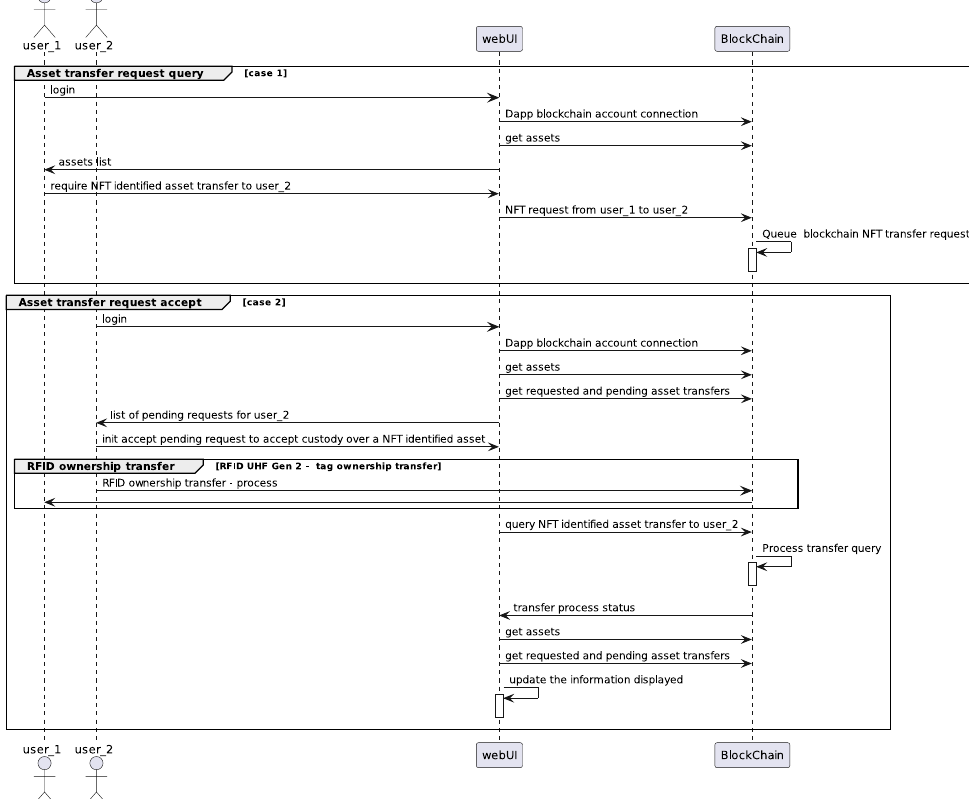
Figure 6. Ownership transfer query and accept